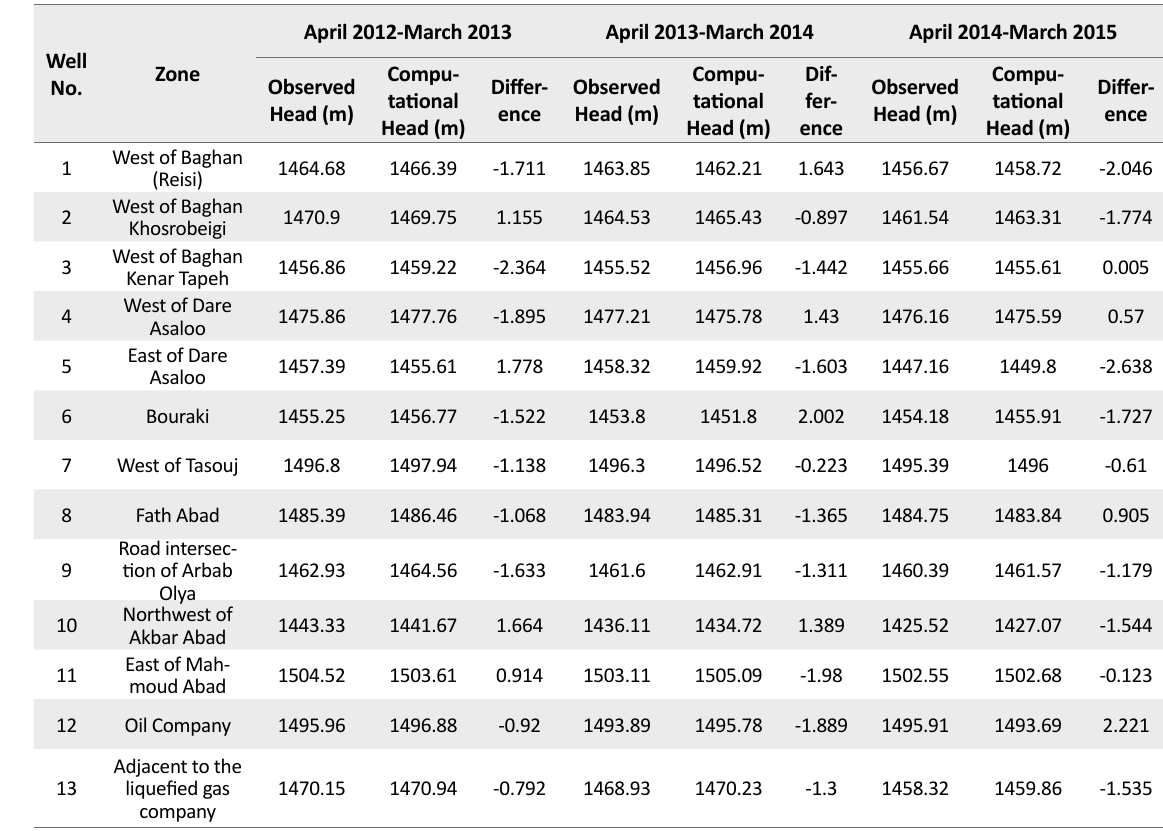
April 2014-March 2015April 2013-March 2014April 2012-March 2013